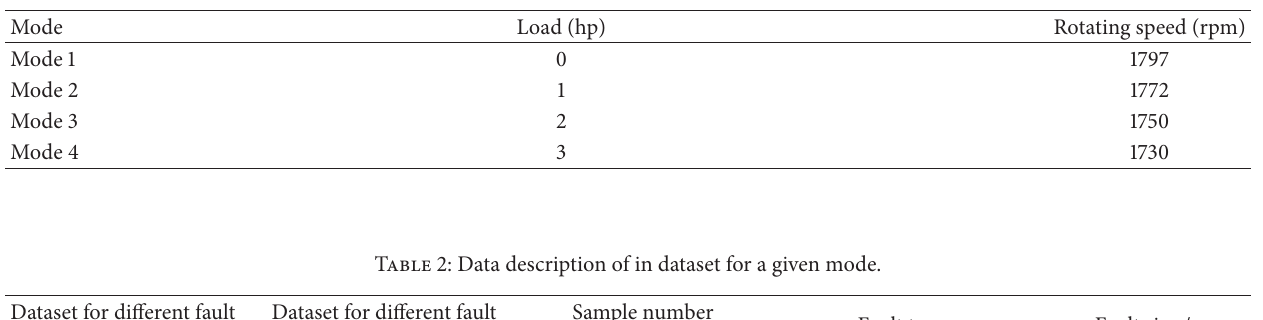
Table 1: Four modes of rolling bearing.